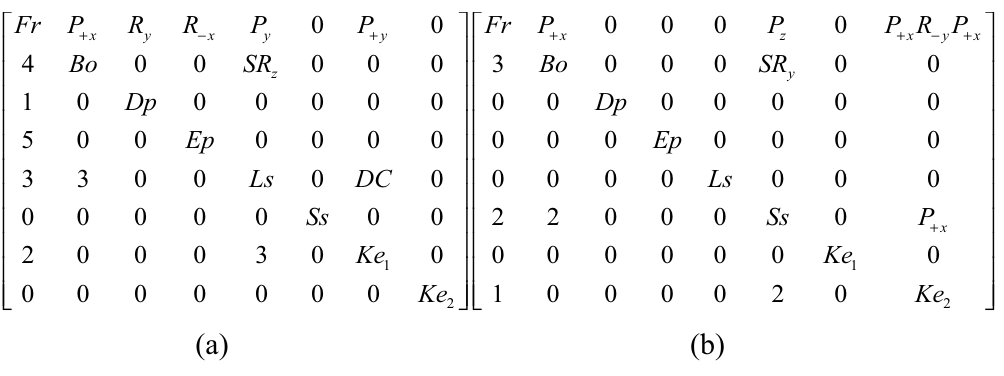
Figure 13. Topology matrix of rotating ornament lock.